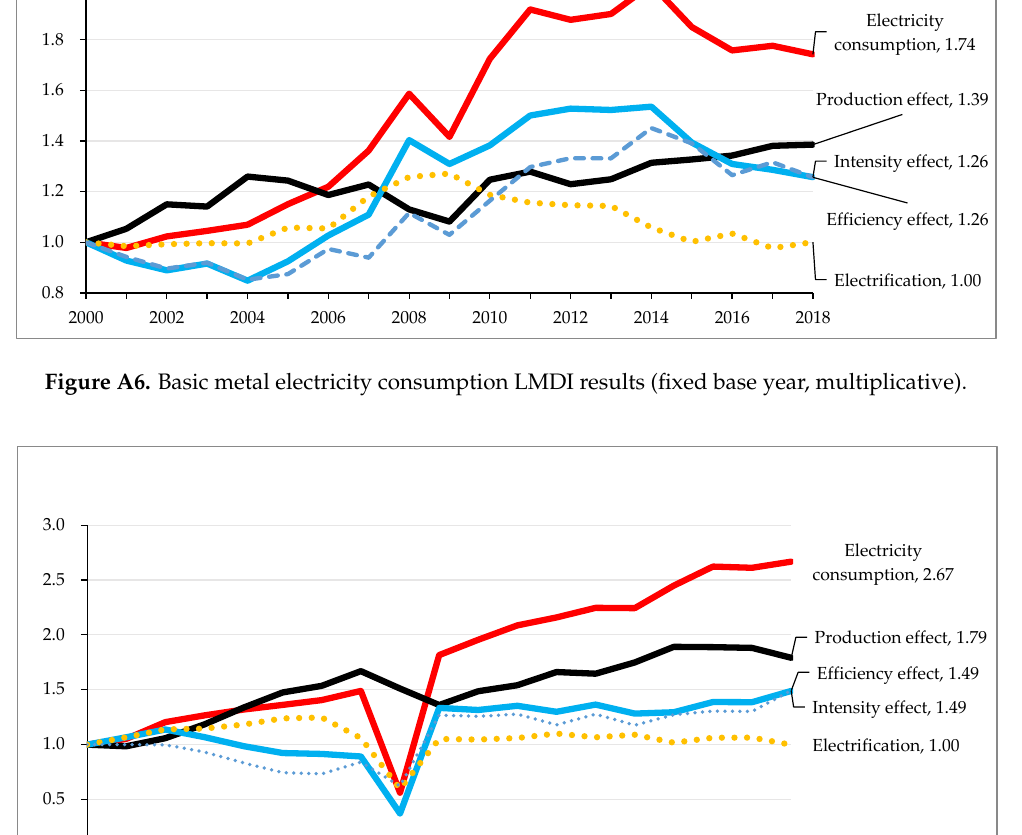
Figure A7. Nonferrous metal electricity consumption LMDI results (fixed base year, multiplicative).